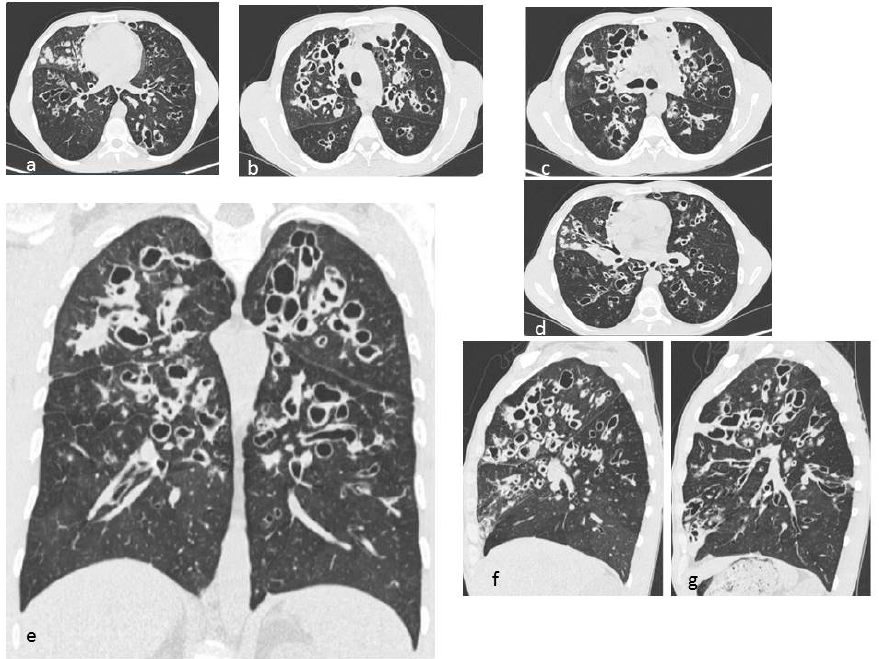
Figure 18. CF, multiple cystic bronchiectases, filled by mucous secretion, abscess cavities or bullae, mainly located in subpleural and middle and upper lung regions ( a , b , c , d ). Multiplanar reconstruction (MPR) in the coronal ( e ) and sagittal planes ( f , g ).